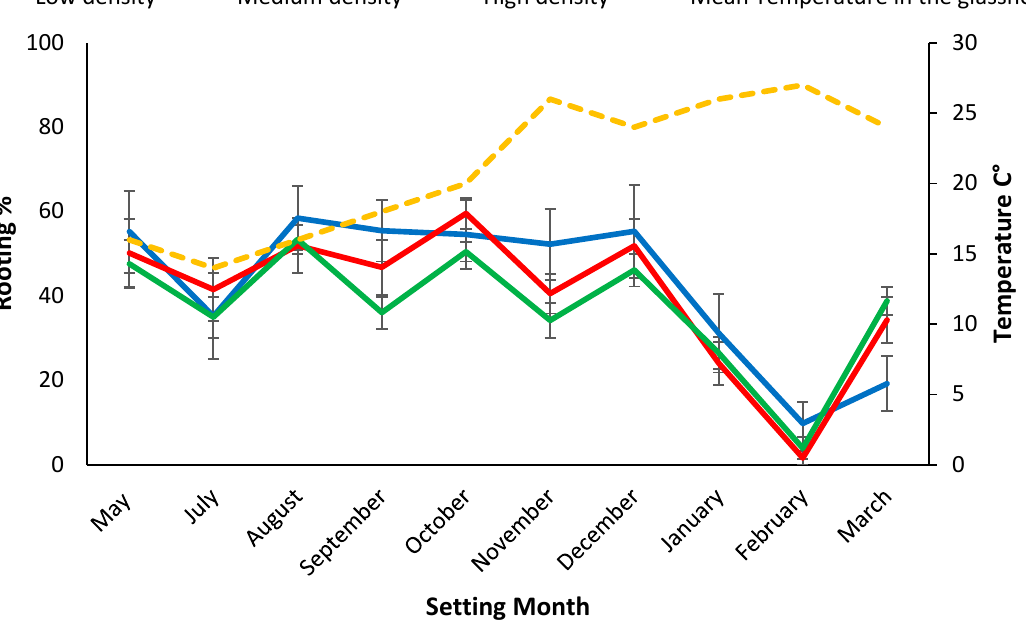
Figure 3. Setting date means (i.e., data pooled densities) for rooting rate% 28 days post setting for mini cutting from coir and mean temperature inside the glasshouse during setting months. Bars represent SE.